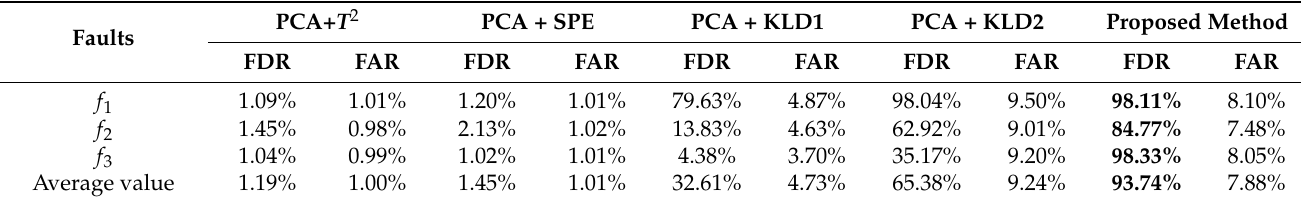
Table 1. Comparison of the performance of five different methods at detecting the three